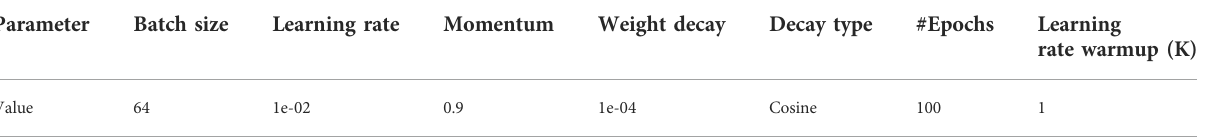
TABLE 3 Parameters considered for training models.